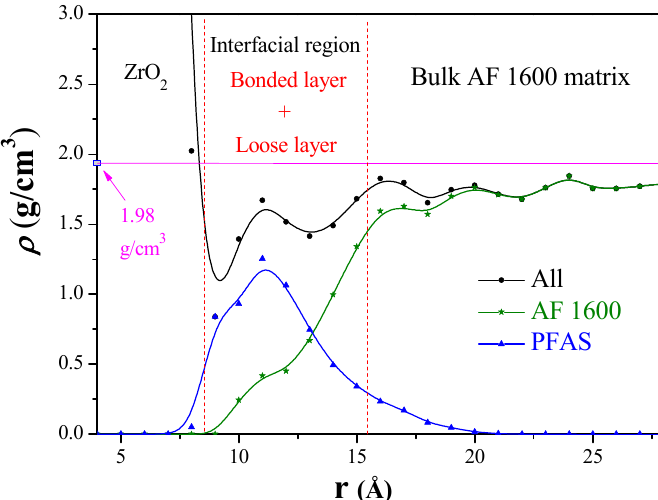
Figure 5. Density distribution around the center of ZrO 2 in the mZrO 2 @AF 1600 nanocomposite. The content of mZrO 2 is 5 wt %, and the radius of mZrO 2 is approximately 8 nm.